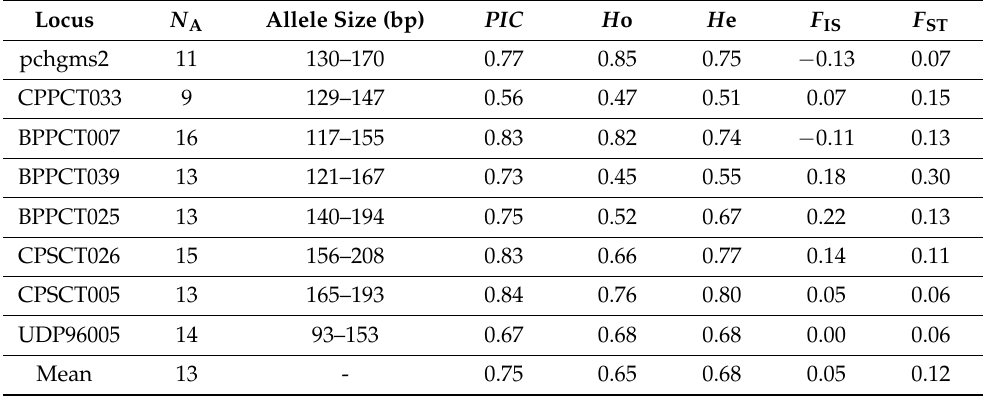
Table 3. Number of alleles and allele size range in base pairs amplified by eight polymorphic SSR in Japanese plum-type accessions. Number of alleles ( N A ), Polymorphism Information Content ( PIC ), Observed heterozygosity ( H o), Expected heterozygosity ( H e), Inbreeding coefficient ( F IS ), and Wright’s Fixation index ( F ST ). N A Allele Size